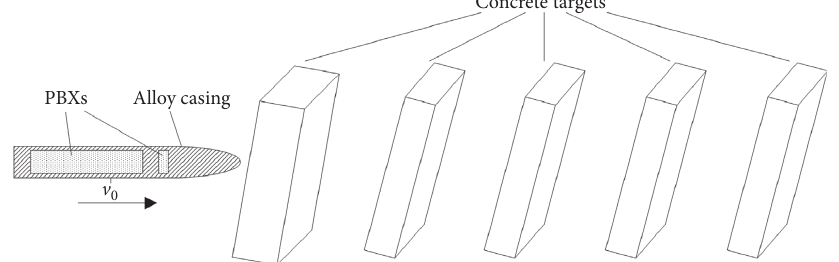
Figure 1: The architecture of the MTP